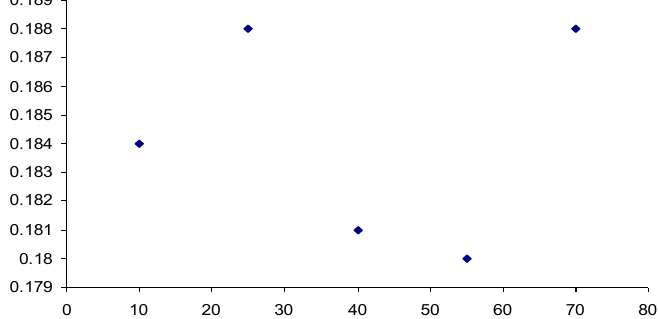
Figure 3. Effect of the average scan s per spectrum employed to carry out the instrumental measurements. The study was carried out using a standard with 1 mgg -1 concentration and the measurements were obtained working with height values for the 1704 cm -1 with a baseline correction between 1850 and 1550 cm -1